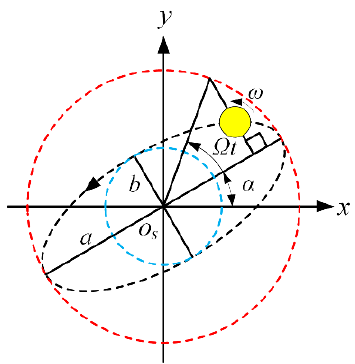
Figure 2. Elliptical orbit whirl model. The blue circle and red circle are auxiliary circles that help to locate the position of the whirl rotor. The diameter of the red circle is the major axis of the ellipse, and the diameter of the blue circle is the minor axis of the ellipse.